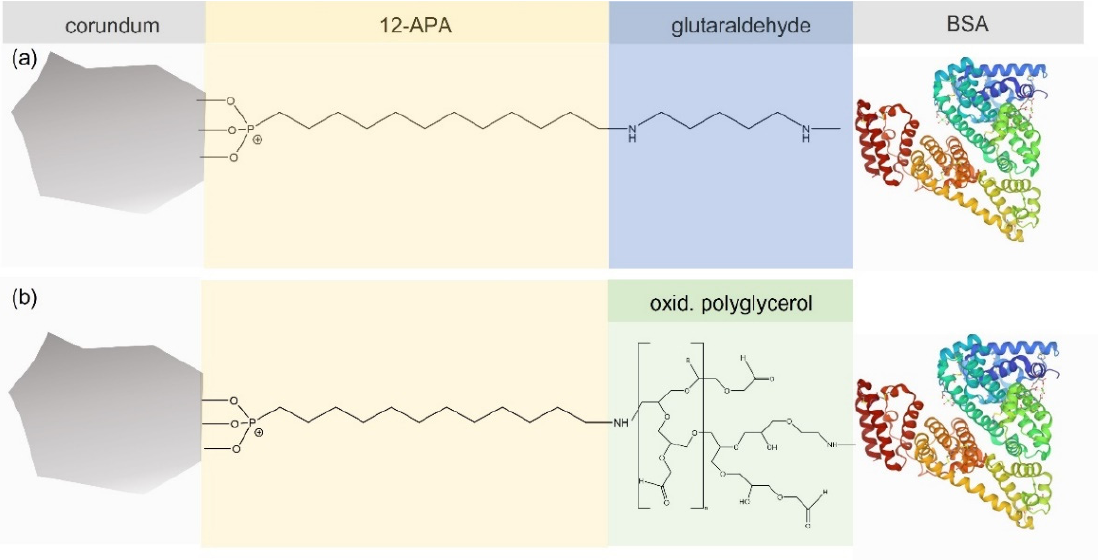
Figure 3. A simplified scheme of corundum particles modified with 12-aminododecylphosphonic acid (12-APA), the ( a ) crosslinkers glutaraldehyde, or ( b ) oxidized polyglycerol, respectively, and finally conjugated to bovine serum albumin (BSA); Structures are not to scale; BSA structure from [45].